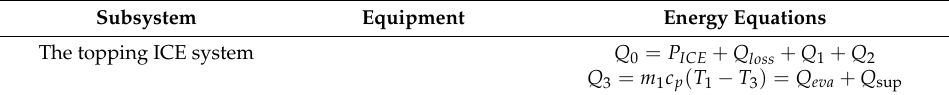
Table 1. Energy relations for equipment of the ICE-Kalina